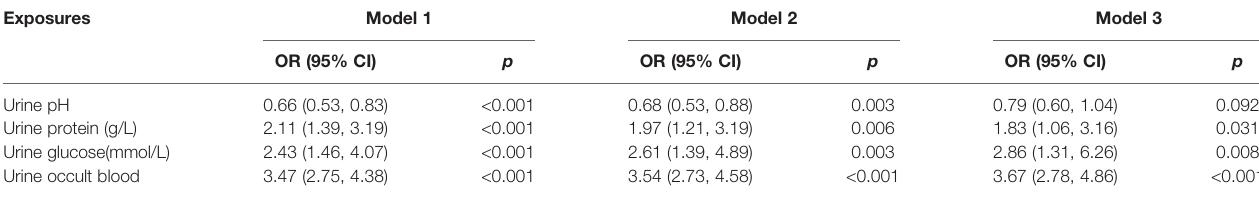
TABLE 3 | Multivariate conditional logistic regression analysis with confounders adjustment.